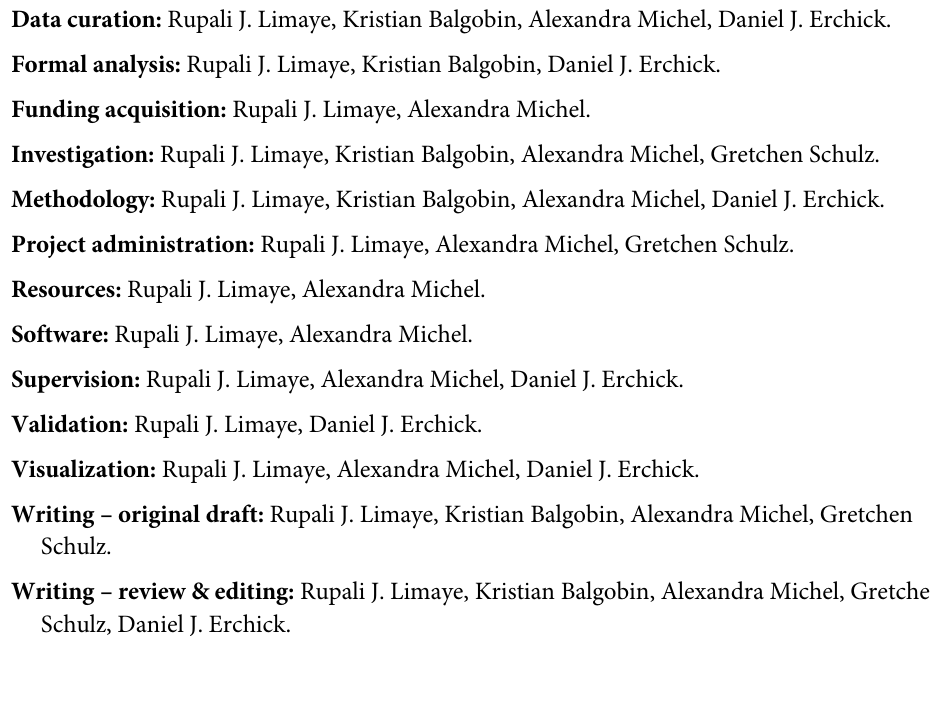
S1 Table. India relative risk ratios of ad preference by vaccine hesitancy status and partici- pant characteristics using multivariable multinomial logistic regression modeling. S2 Table. Indonesia relative risk ratios of ad preference by vaccine hesitancy status and participant characteristics using multivariable multinomial logistic regression modeling. S3 Table. Kenya relative risk ratios of ad preference by vaccine hesitancy status and partici- pant characteristics using multivariable multinomial logistic regression modeling. S4 Table. Nigeria relative risk ratios of ad preference by vaccine hesitancy status and par- ticipant characteristics using multivariable multinomial logistic regression modeling. S5 Table. Ukraine relative risk ratios of ad preference by vaccine hesitancy status and par- ticipant characteristics using multivariable multinomial logistic regression